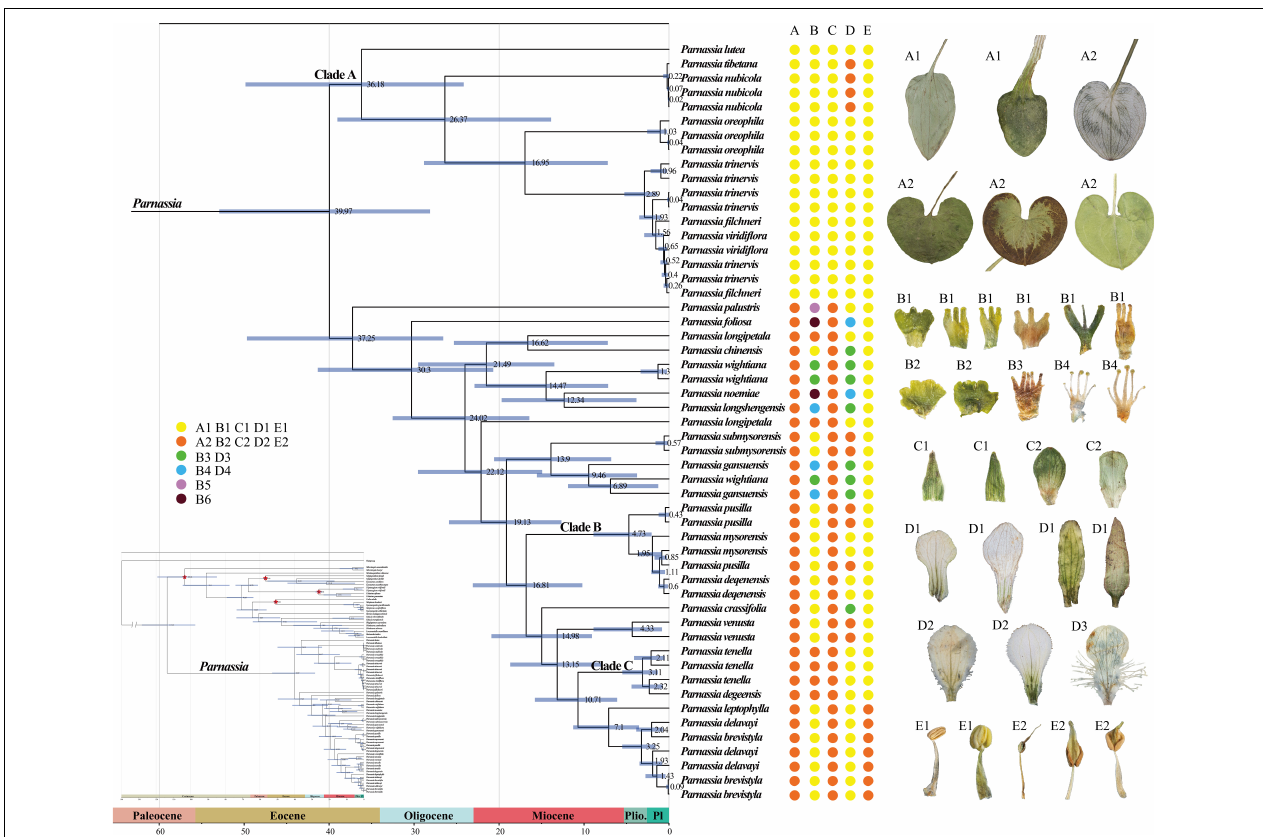
FIGURE 3 | The dated phylogenetic tree of Parnassia is based on the dataset (4). Numbers associated with branches represent the mean estimated divergence time (Mya) and the blue bars correspond to the 95% highest posterior density (HPD) of divergence time. Red stars indicate four calibrating points. Pl, Pleistocene; Plio., Pliocene. (A–E) represent radical leaf, staminode, sepal, petal, and anther connective type, respectively. It should be noted that the characters shown in the figure only represent the characteristic types rather than the actual performance of the species. For a description of the specific feature types, please see